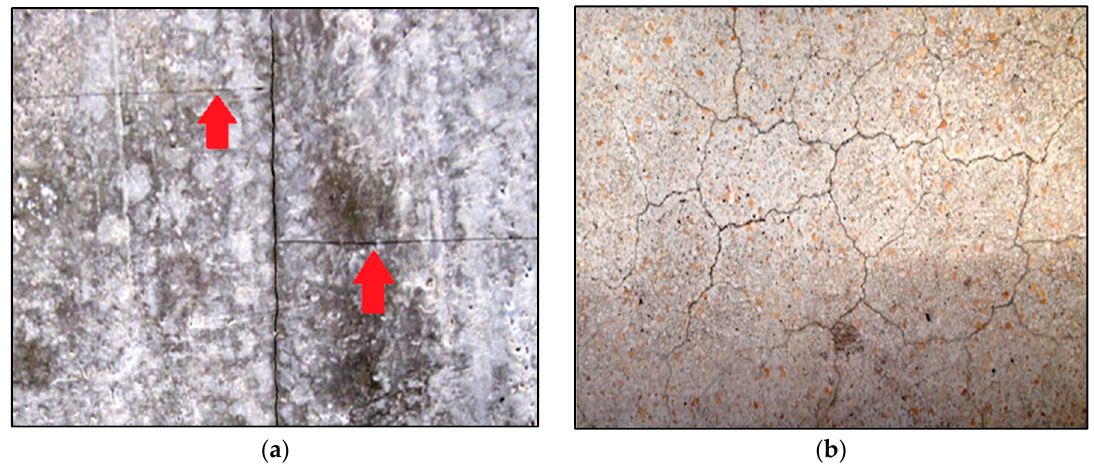
Figure 13. Cracks in concrete ( a ) T-junctions ; ( b ) mostly Y-junctions (photos of existing structures).